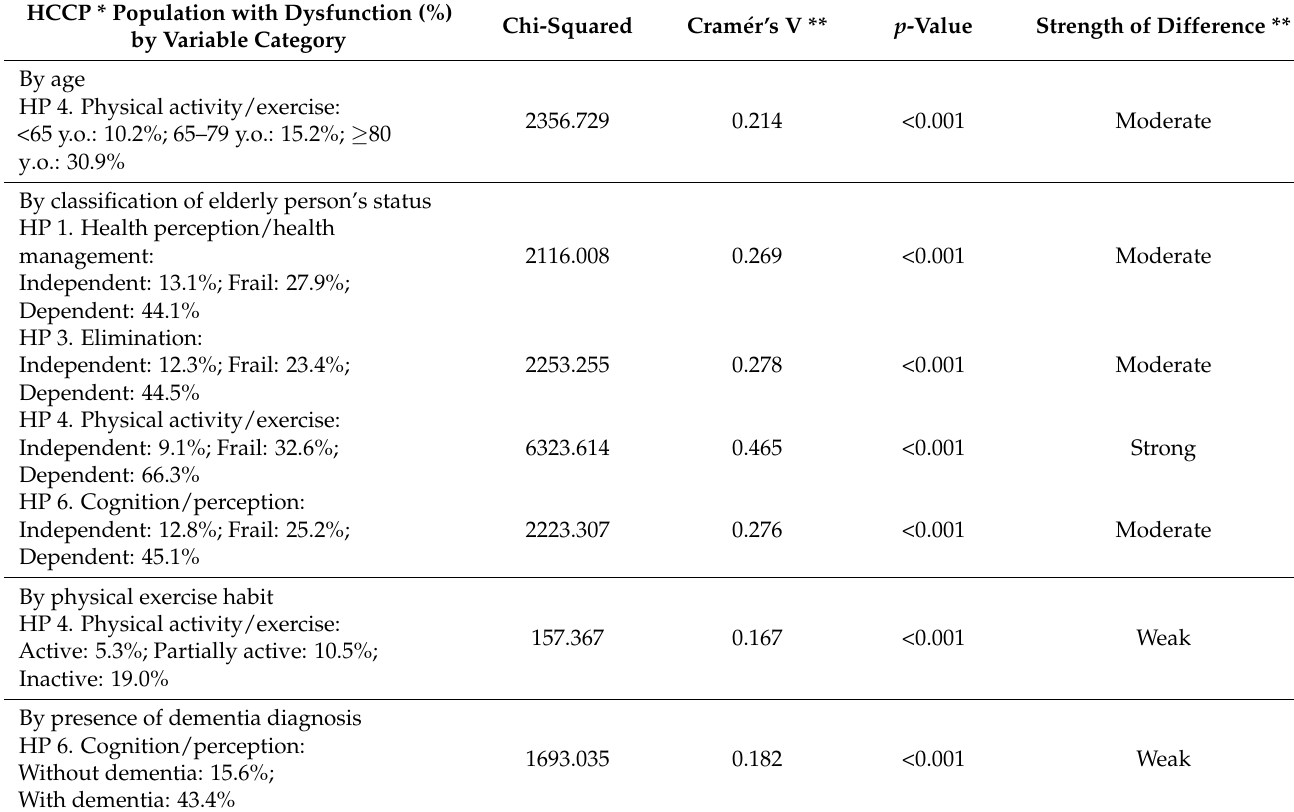
Table 5. Tests of association between dysfunction by health pattern (HP) and patient